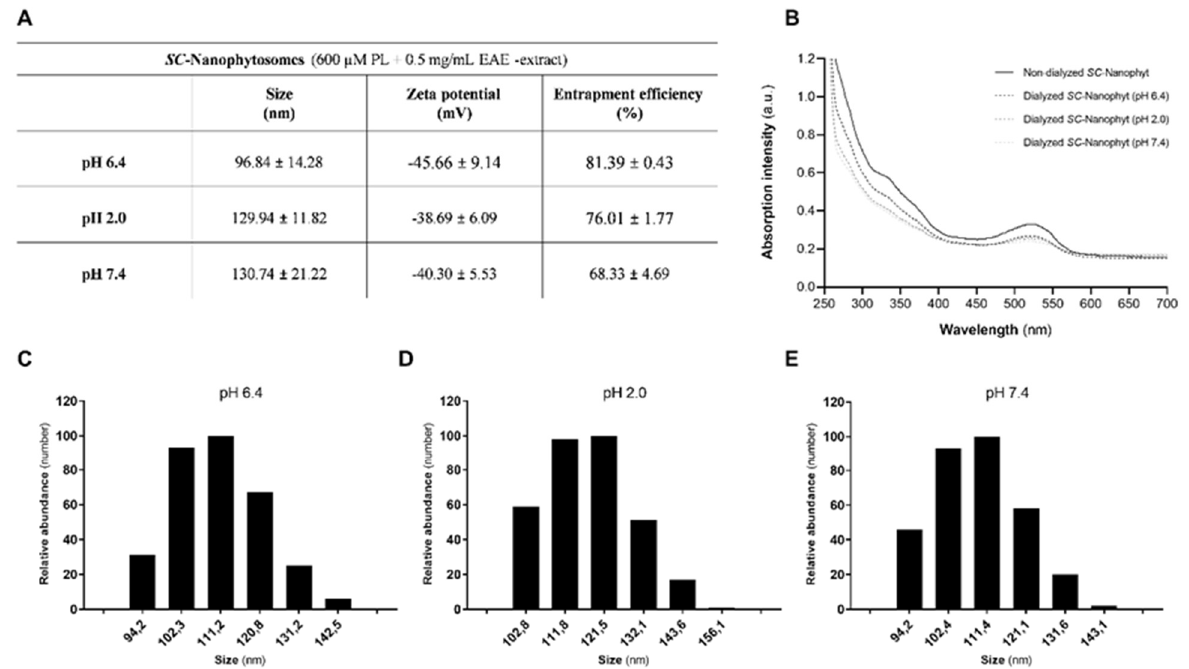
Figure 1. ( A ) Characterization of the dialyzed SC -Nanophytosomes (600 µM in phospholipid and 0.5 mg/mL EAE-extract) against buffer with different pH (6.4, 2.0, and 7.4) in terms of vesicle size (nm), Zeta potential (mV), and the entrapment efficiency (%). ( B ) Typical UV-Visible absorption spectra (250–700 nm) of the EAE-extract of non-dialyzed and dialyze SC -Nanophytosomes at pH 6.4, 2.0, and 7.4. ( C–E ) Typical plots of the size distribution of dialyzed SC -Nanophytosomes at pH 6.4 ( C ), 2.0 ( D ), and 7.4 ( E ).